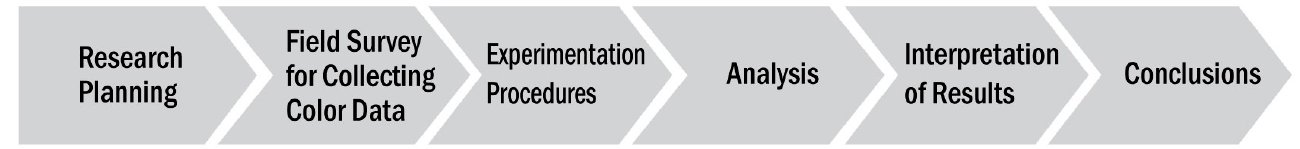
Figure 2. Study design.